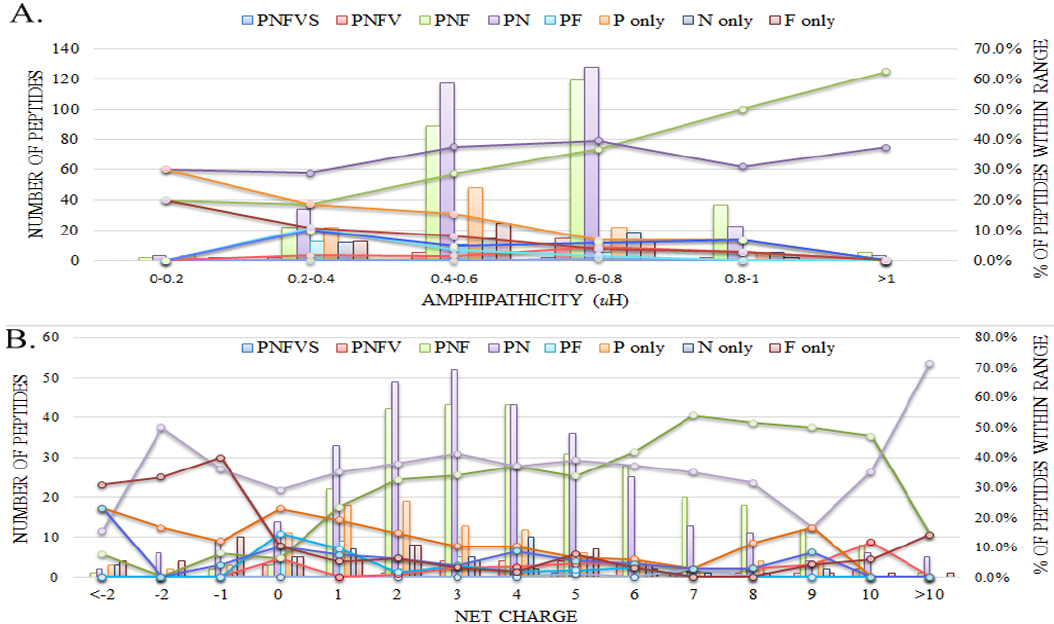
Figure 1. Distributions of antimicrobial activities of AMPs with respect to ( A ) amphipathicity and ( B ) net charge. The distribution of the AMPs with specific antimicrobial activities is displayed using a histogram on the left axis, and the percentages of the AMPs with specific antimicrobial activities in the specific range are demonstrated using a line chart on the right axis. Abbreviations: P: anti-gram-positive bacteria; N: anti-gram-negative bacteria; F: anti-fungi; V: anti-viruses; S: